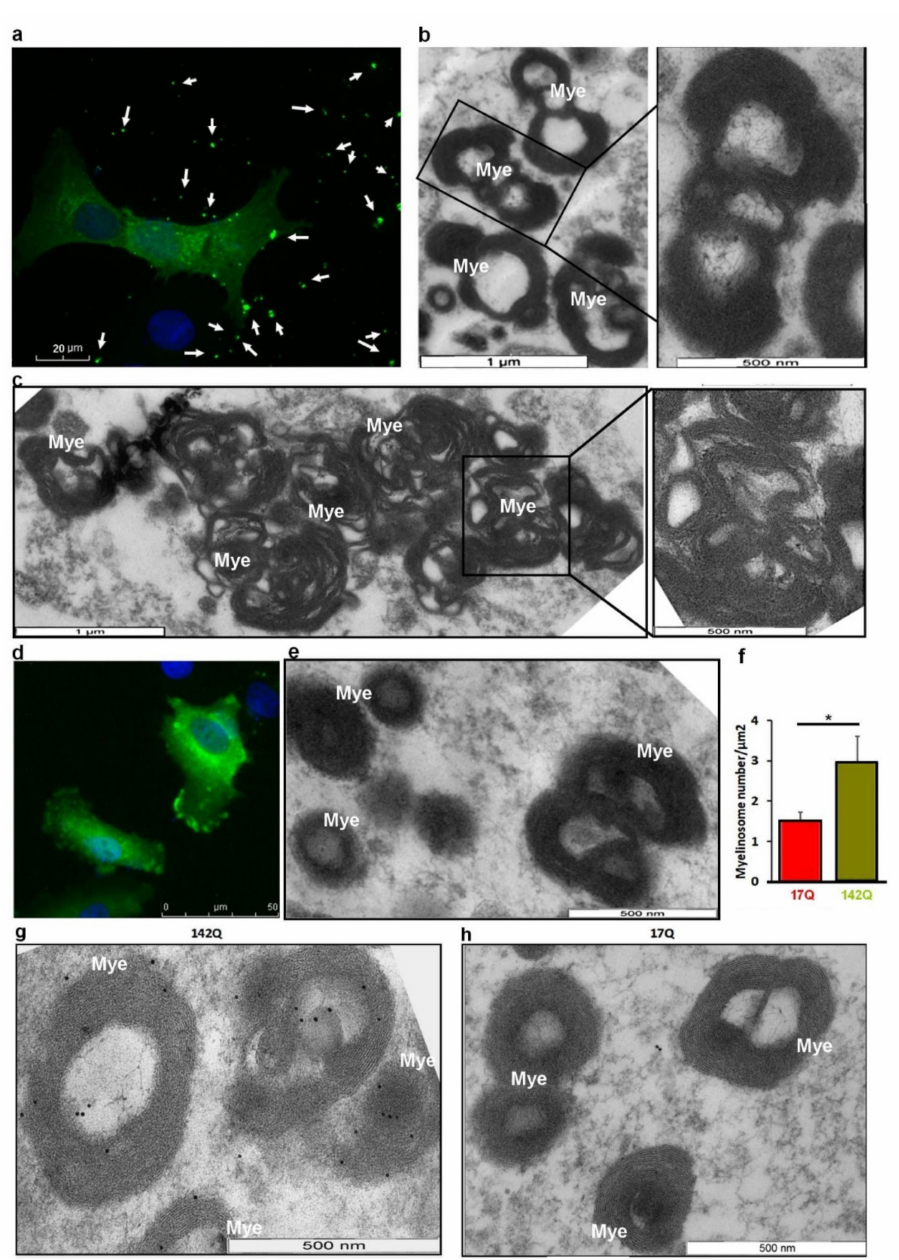
Figure 3. MIO-M1 Müller cells produce myelinosomes. ( a ) IF pictures of MIO-MI cells expressing EGFP-mHTT-exon1 48 h post-transfection. Arrows denote green-colored extracellular spots in the vicinity of cells. ( b ) Myelinosome vesicles isolated from 20,000 g culture media pellets of MIO-M1 Müller cells expressing EGFP-mHTT-exon1. Right panel is a magnification of a selection from the left panel. ( c ) Agglomerated myelinosomes from MIO-M1 Müller cells expressing EGFP-mHTT-exon1. Note the “loose” aspect of myelinosomes, probably due to their immature state. Right panel is a magnification of a selection from the left panel, showing the decreased density of osmiophile membrane packaging. ( d ) IF pictures of MIO-MI cells expressing EGFP-HTT-exon1 48 h post-transfection. Note the absence of extracellular green staining. ( e ) Myelinosomes isolated from 20,000 g culture media pellets of MIO-M1 Müller cells expressing EGFP-HTT-exon1. Right panel is a magnification of a selection from the left panel. ( f ) Histogram representing quantification of myelinosomes isolated from the preparations of 20,000 g culture media pellet of MIO-M1 Müller cells expressing EGFP-HTT-exon1 (17Q) and EGFP-mHTT-exon1 (142Q) protein.* p < 0.05 by two-tailed Student’s t test. ( g , h ) Immunogold labeling of 20,000 g culture media pellet of MIO-M1 Müller cells transfected with EGFP-mHTT-exon1 ( g ) and EGFP-HTT-exon1 ( h ) with anti-EGFP antibody. Note that gold particles are only associated with myelinosomes from MIO-M1 Müller cells transfected with EGFP-mHTT-exon1 ( g ). Abbreviations: